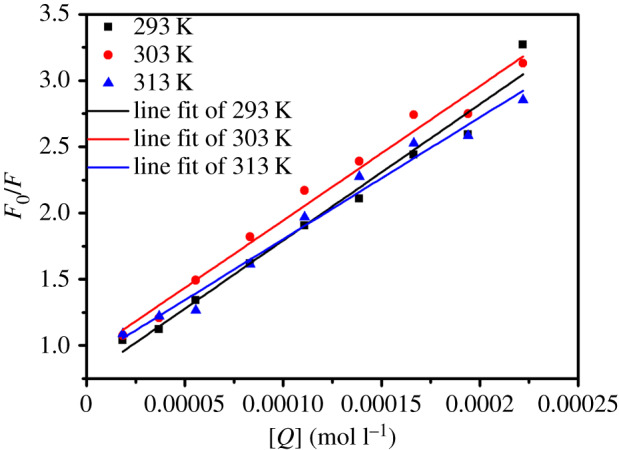
Stern–Volmer plots for the quenching of BSA by SiO2@GdPO4:Tb@SiO2 at different temperature.